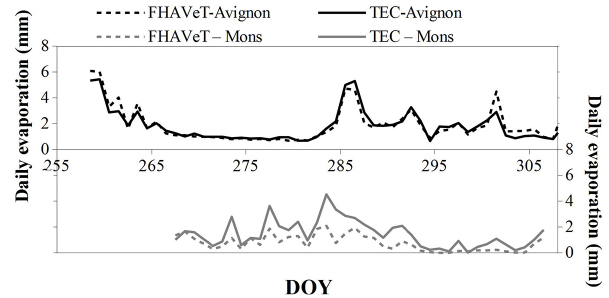
Figure 7. Daily evaporation (in mm) evolution in time; comparison between models – Soil AL-SiL, PTF – Wosten.